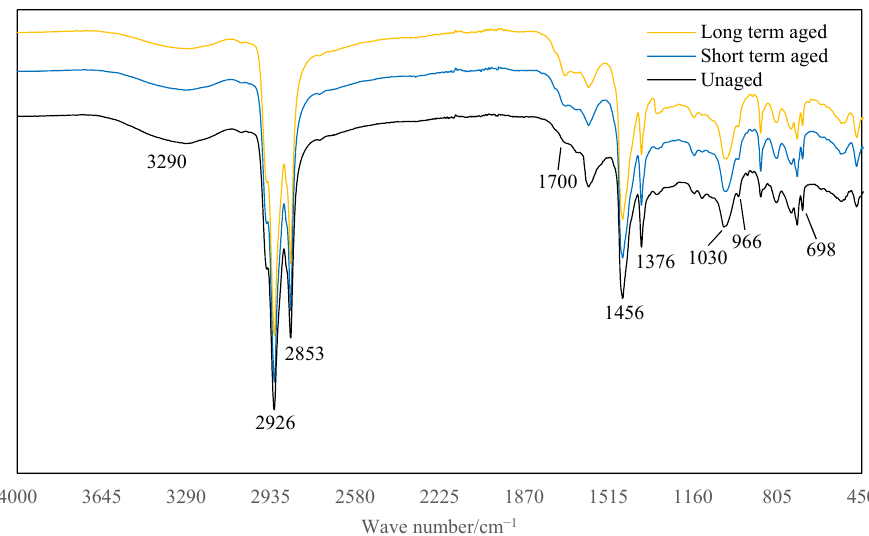
Figure 9. FTIR spectrum of asphalt extracted from ALSMA-13.